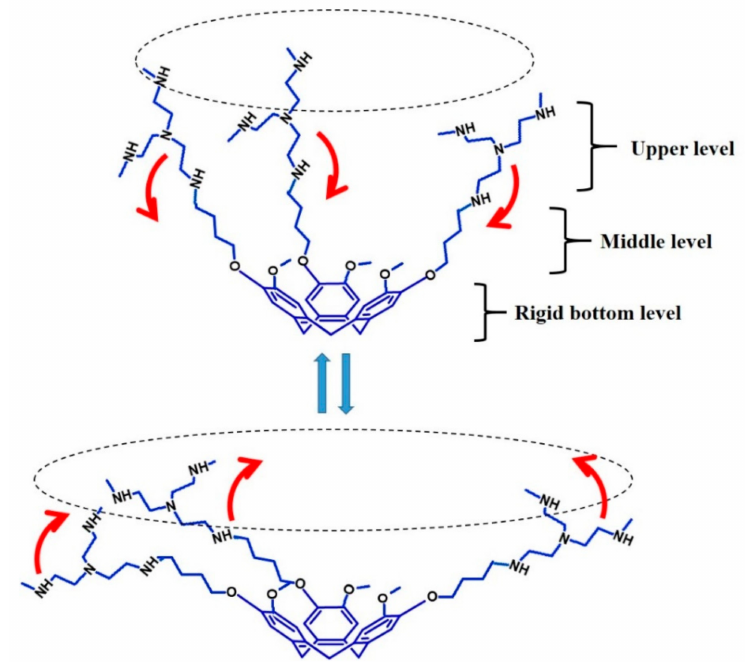
Figure 2. A pictorial description of the hollow structure inside the polymeric network. The flexibility of the alkyl chains that arm the CTV unit induces the variability of the diameter of the hollow unit and the hosting space